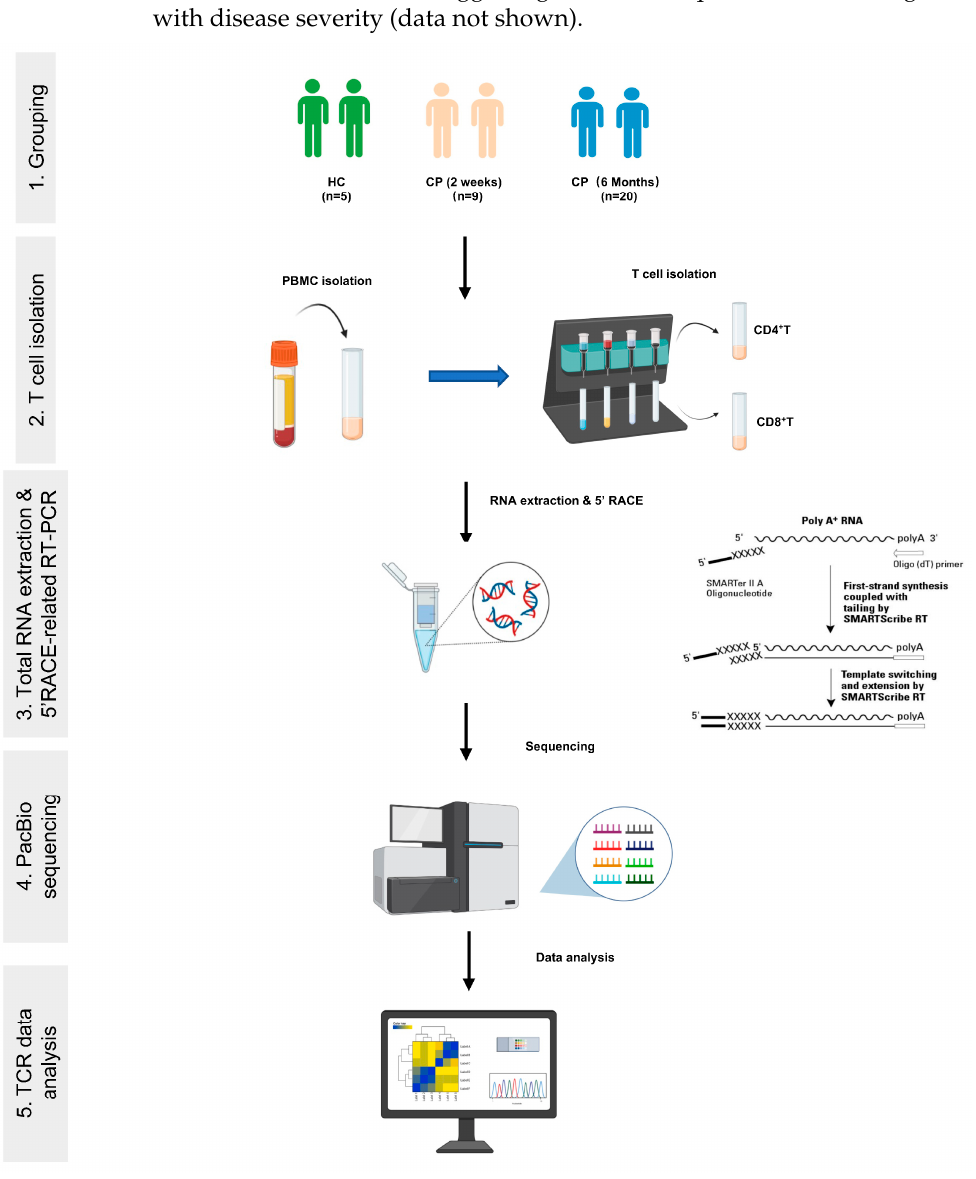
Figure 1. Schematic diagram of TCR repertoire analysis in the convalescent COVID-19 patients. Peripheral blood mononuclear cells were collected from COVID-19 patients with 2-week and 6-month convalescence phase and healthy controls, and CD4 + T and CD8 + T cells were sorted to perform 5 ′ RACE-related RT-PCR combined with PacBio sequencing. Table 2. The total number of TCR α and β chain sequences were obtained.